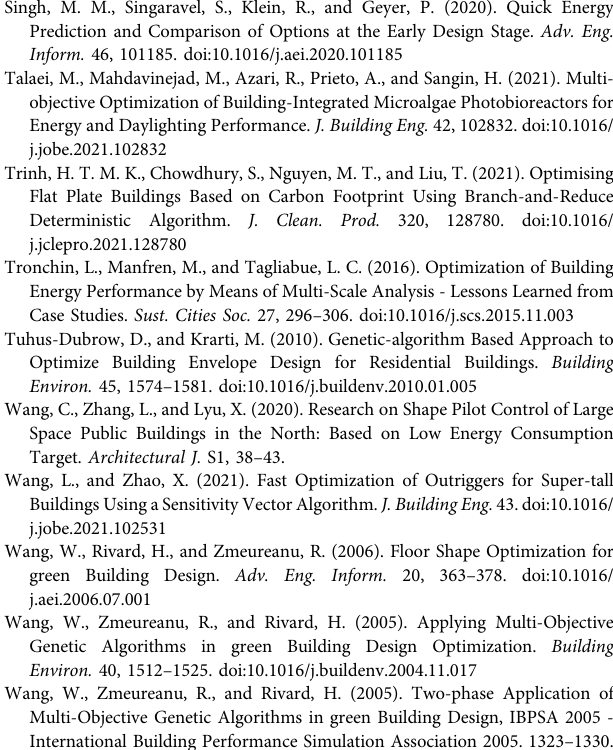
Algorithm (GA) for Tall Apartment ’ s Solar Right. Solar Energy 113, 236 – 250.